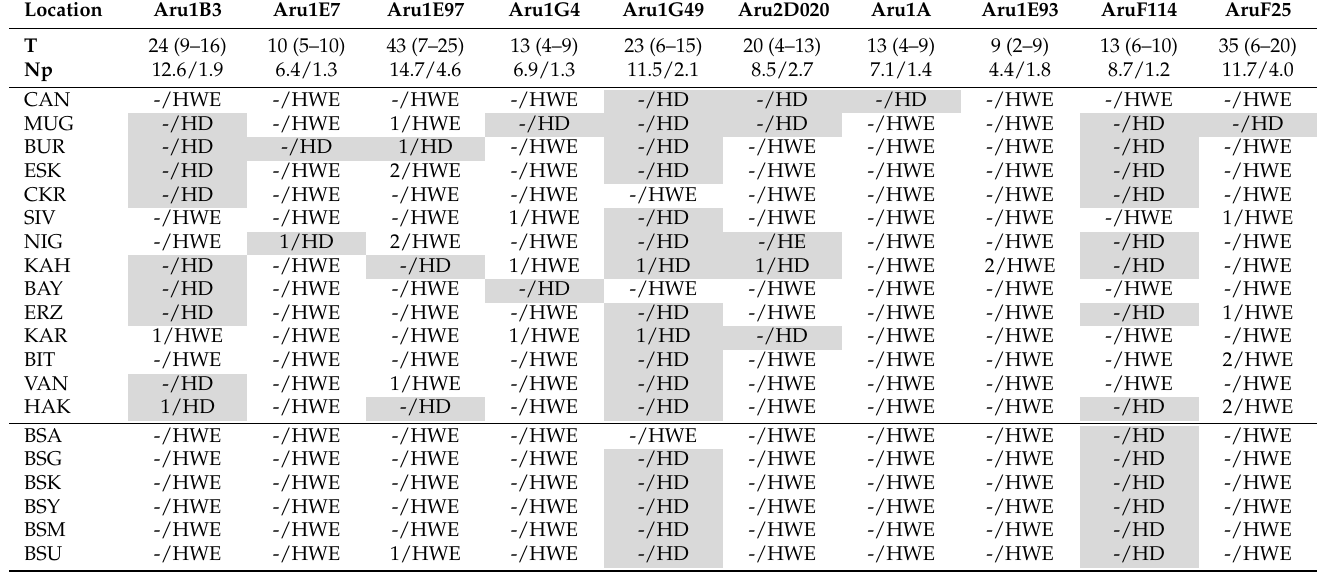
Table 5. Microsatellite polymorphism. T: total number of alleles (range), Np: mean the number of alleles per population ± SD, HWE: Hardy–Weinberg equilibrium, HD: Heterozygote deficiency, HE: Heterozygote excess, values: the number of specific alleles in each